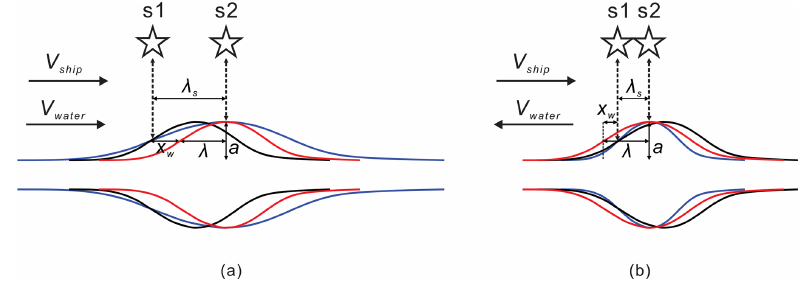
Figure 2. Schematic diagram of the apparent wavelength correction of the mode-2 ISW. (a) The ISW moves in the same direction as the ship. (b) The ISW moves in the opposite direction to the ship. S1 denotes the self-excitation and self-reception position of the ship at 1 / 2 amplitude of the ISW at the beginning. S2 denotes the self-excitation and self-reception position of the ship at the peak of the amplitude of the ISW. V ship is the ship speed and V water is the ISW propagation speed, λ s is the apparent wavelength of the ISW observed by the seismic stacked section, λ is the actual wavelength of the ISW, a is the amplitude of the ISW, and x w is the distance moved by the ISW during the time the ship moves from S1 to S2. The black curve denotes the ISW at the beginning. The red curve denotes the ISW moved x w distance from the starting position. The blue curve denotes the ISW observed on the seismic stacked